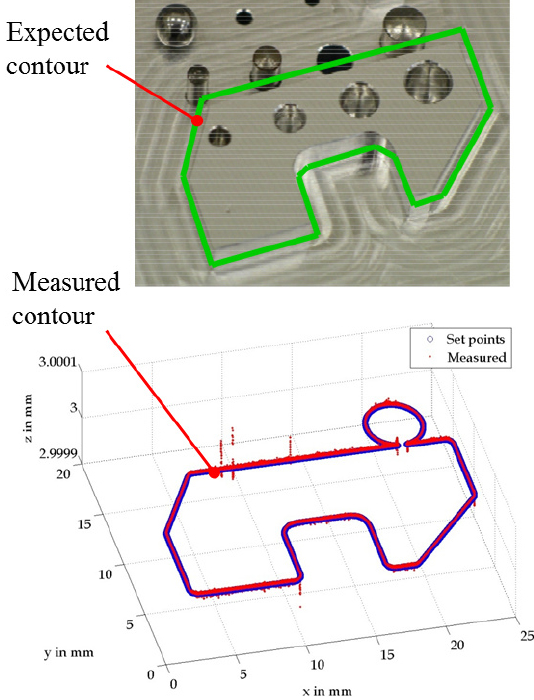
Figure 11. Free-form scan on a sample structure.